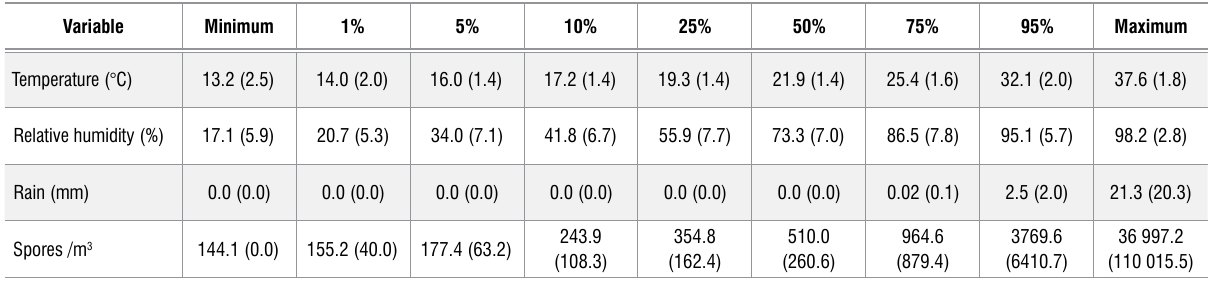
Means and coefficients of variation (%) of quantiles estimated for temperature, relative humidity, rainfall and ascospore numbers measured during the 3775 3-hourly Phyllosticta ascospore release events recorded at 13 localities over one to five seasons Variable